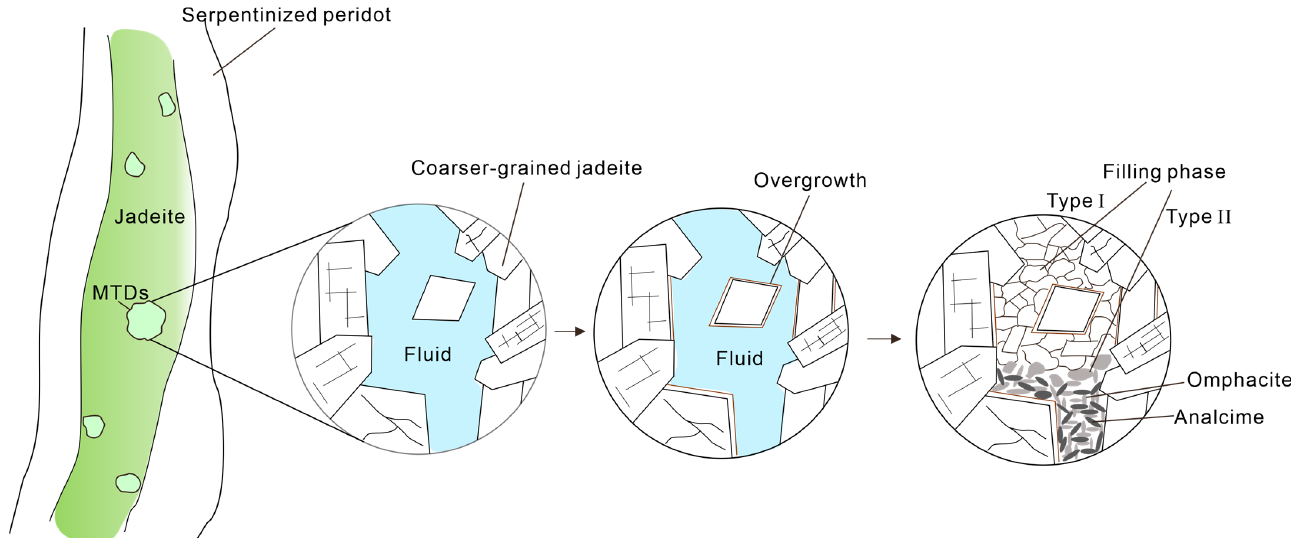
Figure 12. Schematic diagram of the formation process of interstitial textures (from left to right): (1) fluid enters serpentinized peridotite cracks and crystallizes into jadeites; (2) coarse-grained jadeites stop growing and form interspaces and interspaces; (3) relict or later-stage hydrothermal fluids enter the interspaces and form Type I filling grains in the respectively larger space; (4) crystallization continues in the narrow space to form anhedral Type II filling grains, and then analcime forms in crystal interstices, fractures, and hollows.